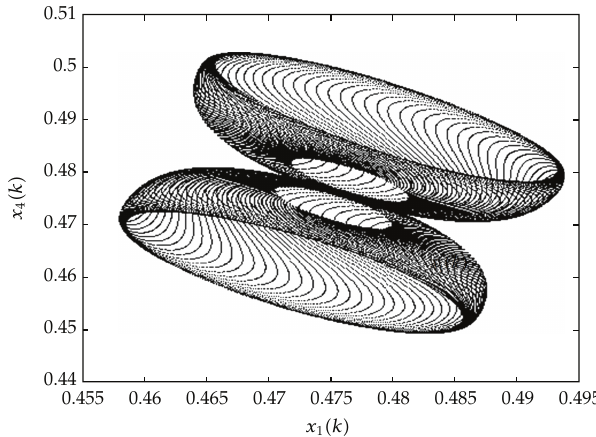
Figure 2: The typical bifurcation solution resulting from the flip-Neimark-Sacker bifurcation of map (cid:4) 4.1 (cid:5) .